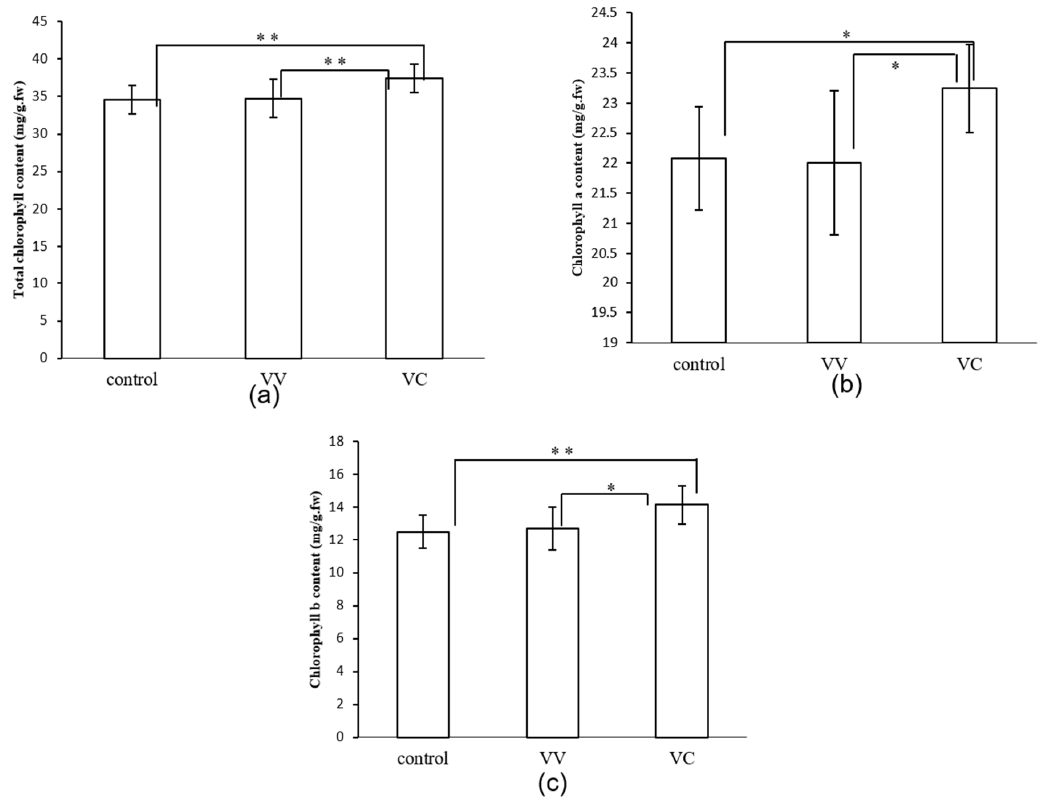
Figure 6. Chlorophyll content in in control, VIGS- vector and VIGS-CtPPO C. terniflora leaves. ( a ) Total chlorophyll content, ( b ) chlorophyll a content, and ( c ) chlorophyll b content. Data are shown as mean ± SD for independent biological replicates. Asterisks indicate significant changes as measured by Student’s t -test (* p < 0.05, ** p < 0.01). fw: fresh weight.